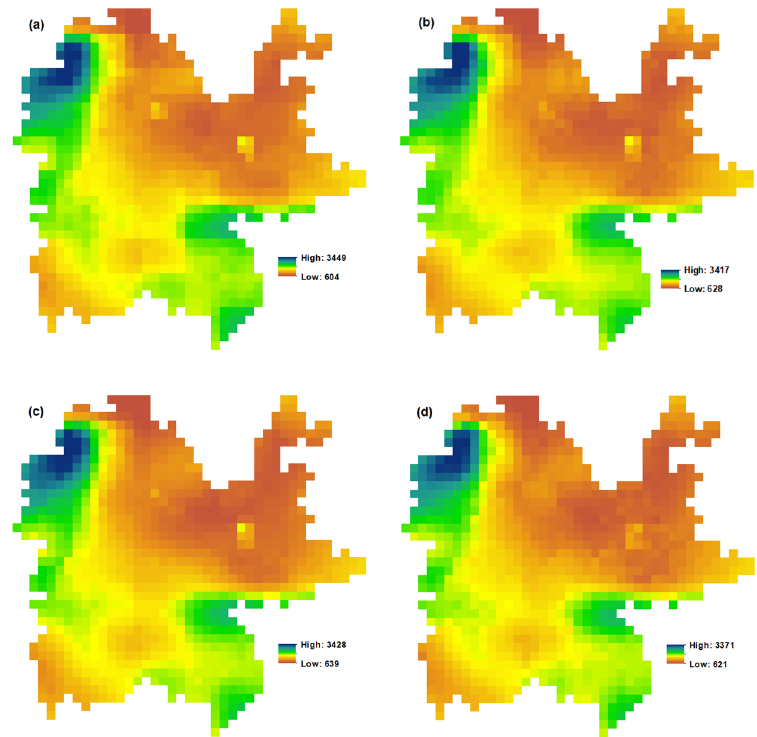
Figure 5. Original TRMM ( a ) and predicted TRMM using ANN algorithm and NDVI ( b ), EVI ( c ), and LAI ( d ) for the year 2018.